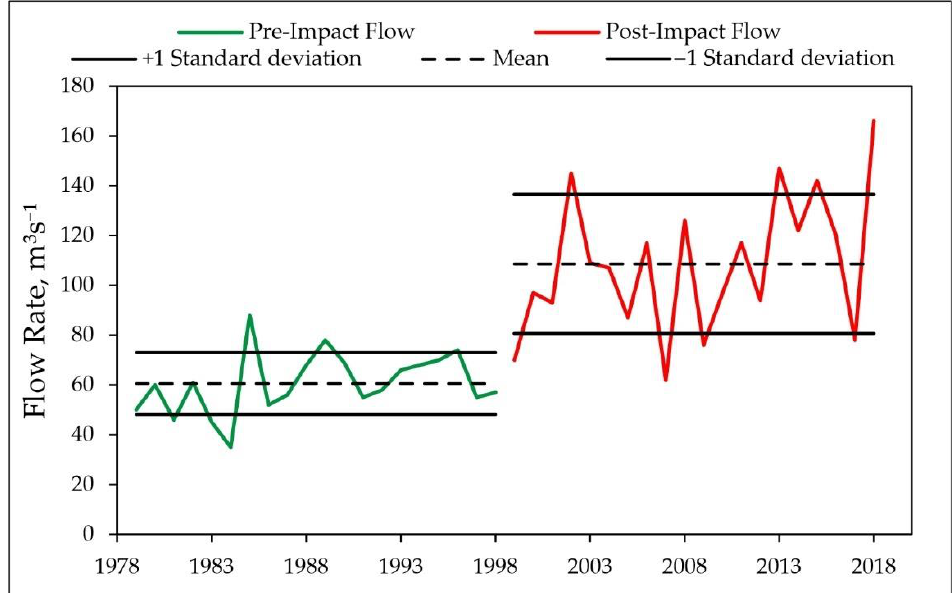
Figure 6. The number of reversals at Lėvuo -Bernatoniai WGS before and after construction of Akmeniai HPP.